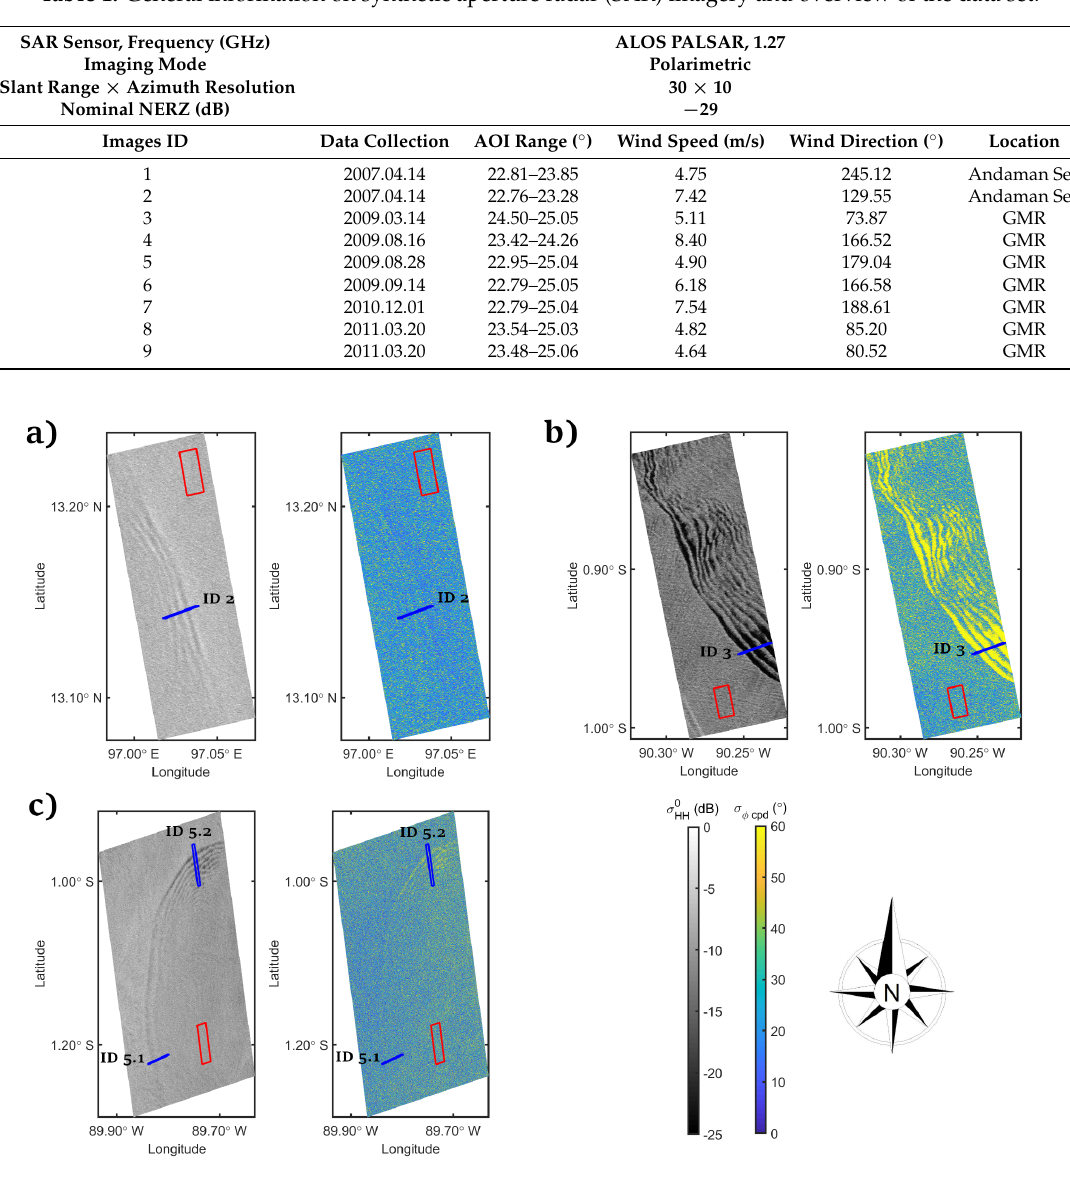
Figure 2. The HH-intensity (left) and standard deviation of co-polarized phase difference (CPD) (right) ALOS-PALSAR (APL) excerpt images showing IW signatures related to: ( a ) Image ID 2 acquired in Andaman Sea on 2007.04.14; ( b ) Image ID 3 acquired in Galapagos Marine Reserve (GMR) on 2009.03.14; and ( c ) Image ID 5 acquired in GMR on 2009.08.28. The selected IW profiles and ROI representing the backgrounds are depicted in blue lines and red rectangles, respectively. Please, note that the profile ID numbers are depicted in the figures. More information about the images can be found in Table